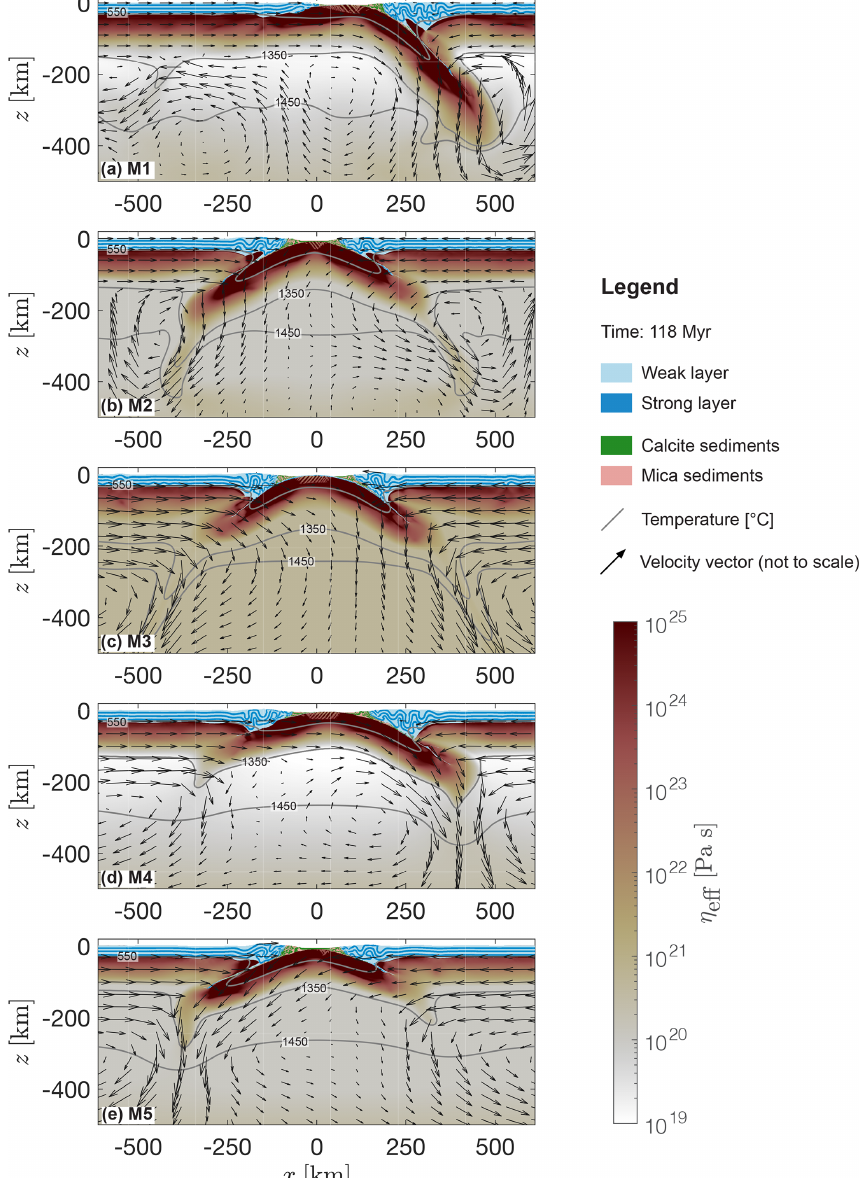
Figure 10. Evolution of subduction zones. (a–e) Results of models M1–5 after 118Myr of simulated deformation. Blue indicates mechani- cally weak (light) and strong (dark) crustal units, and green and salmon indicate the sedimentary units. White to red colours show the effective viscosity field calculated by the numerical algorithm for the mantle lithosphere and the upper mantle. Arrows represent velocity vectors, and the length of the arrows is not to scale. Grey lines indicate the 550, 1350 and 1450 ◦ C